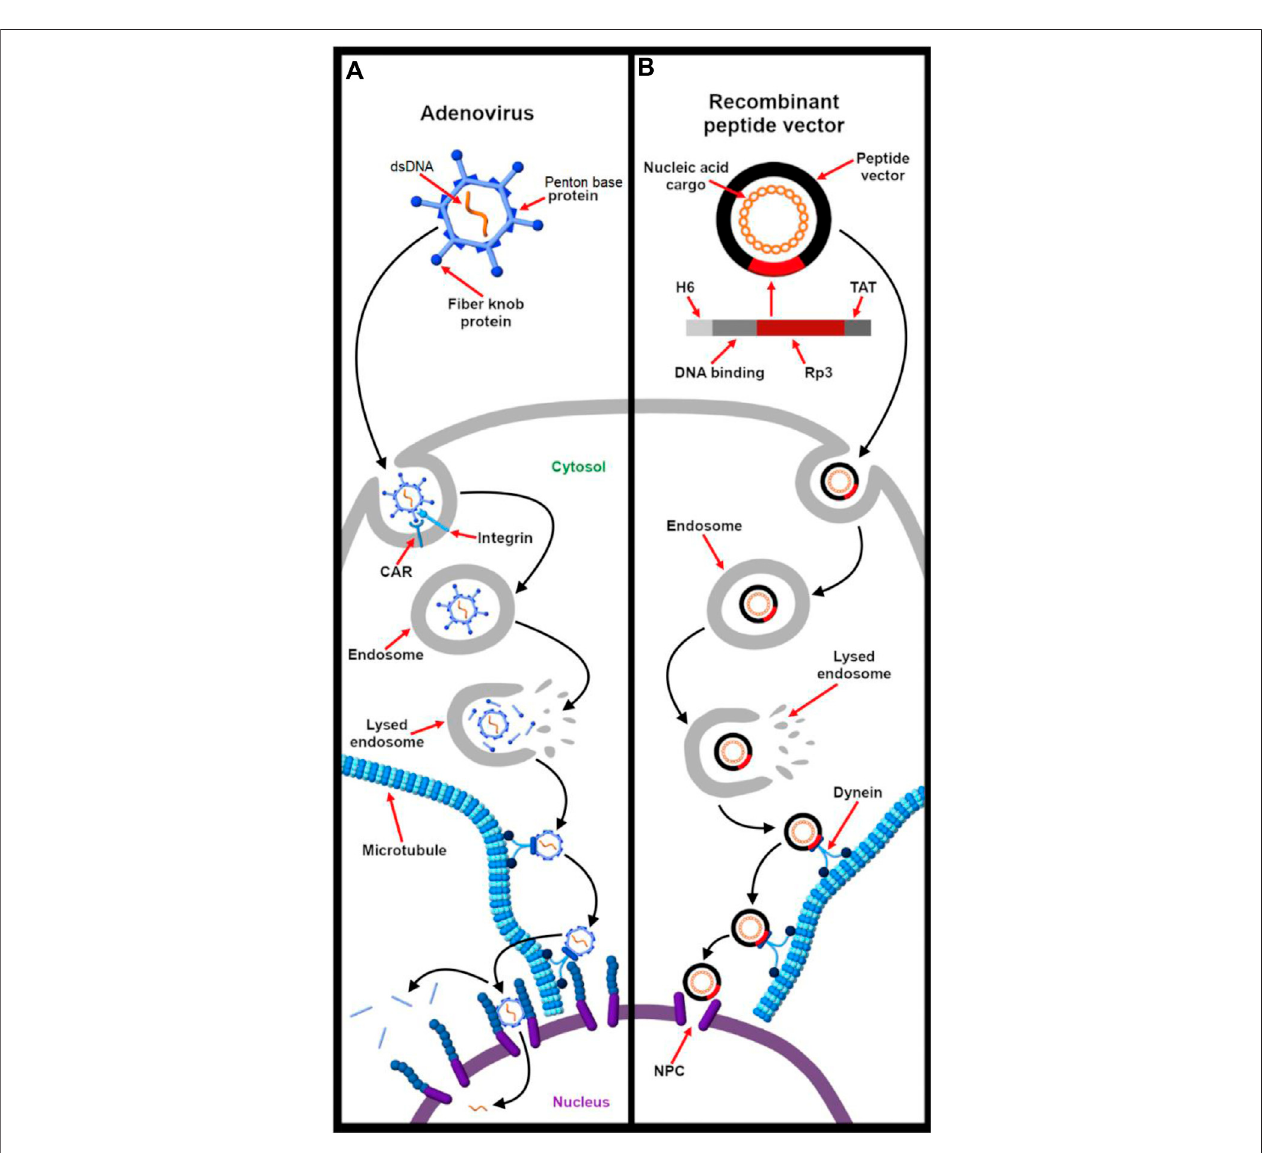
FIGURE 6 | Microtubule (MT)-assisted nuclear delivery of adenovirus mimicked by a recombinant peptide vector. (A) Adenovirus undergoes receptor-mediated endocytosis by targeting CAR and integrin receptors present on the cell surface. Once inside the endosome, protein VI contains an N-terminal amphipathic helix that